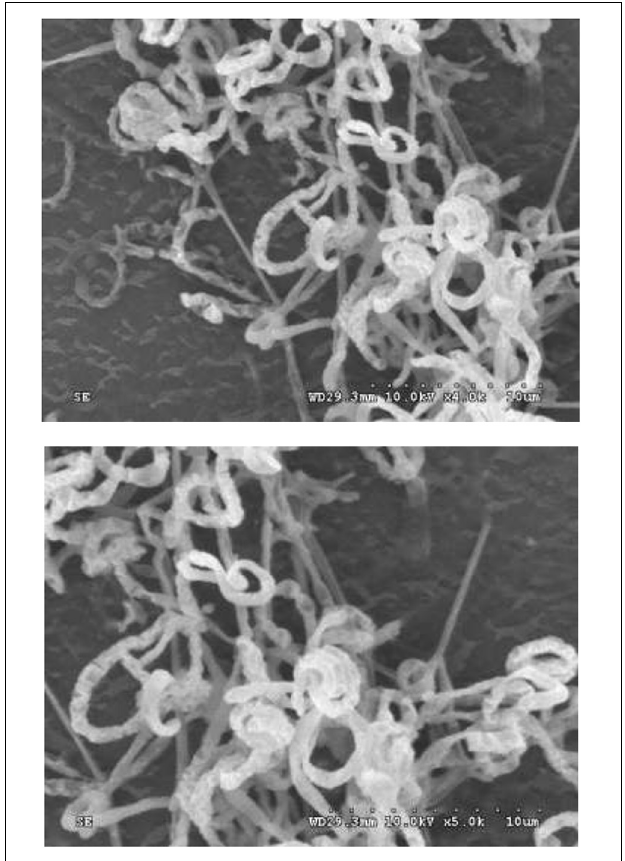
FIGURE 3 | Scanning electron micrograph showing spiral spore chains of strain HNM0039 T after growth on ISP7 medium at 28 ◦ C for 3 weeks. Bars: 10 µ